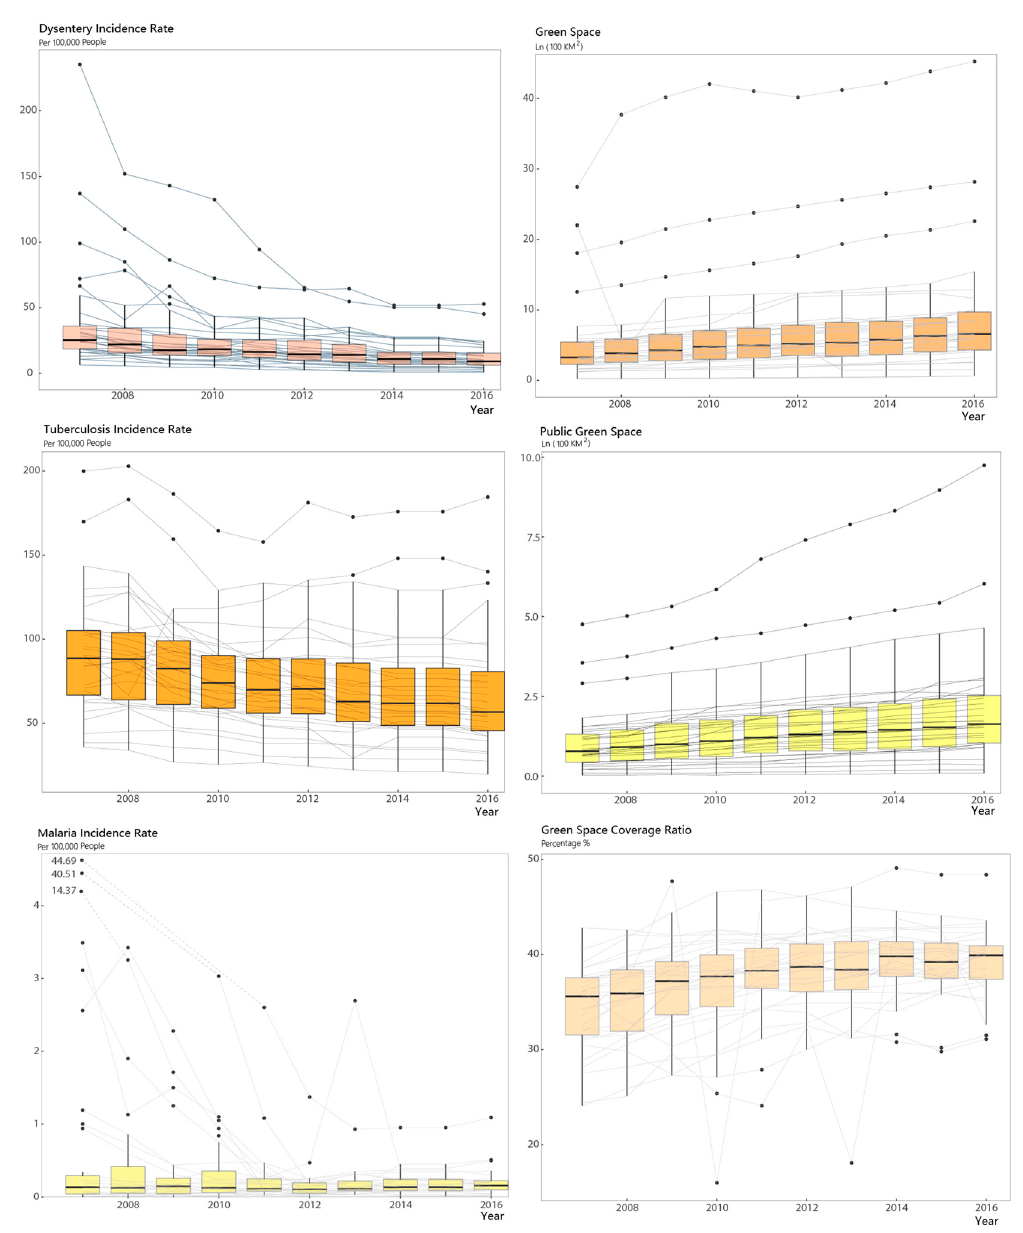
Figure 4. Descriptive statistics of variables.